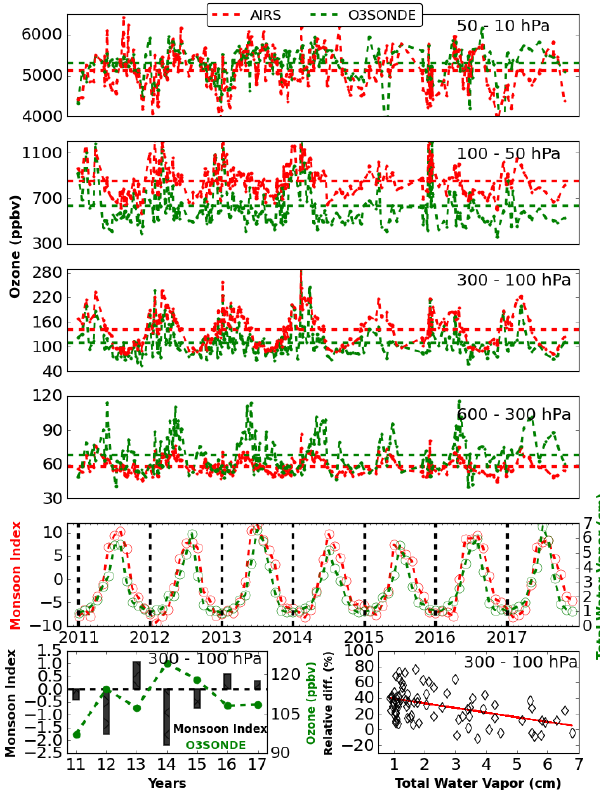
Figure 6. Average variations in ozone mixing ratios at four de- fined layers, characterizing the middle stratosphere (50–10hPa), the lower stratosphere (100–50hPa), the upper troposphere (300– 100hPa), and the middle troposphere (600–300hPa). The dashed horizontal red and green lines show the average ozone mix- ing ratios in the defined layers from AIRS and ozonesonde, re- spectively, from 2011 to 2017. The monthly variation in the total column water vapour (cm) along with the monsoon in- dex is also shown. The yearly average ozone from ozonesonde and monsoon index (bar plot) for different years (lowermost left) and the scatter plot of ozone relative difference (%) ((AIRS − O3SONDE) / O3SONDE) × 100 with total water vapour (lowermost right) in the upper troposphere (300–100hPa) are also shown.